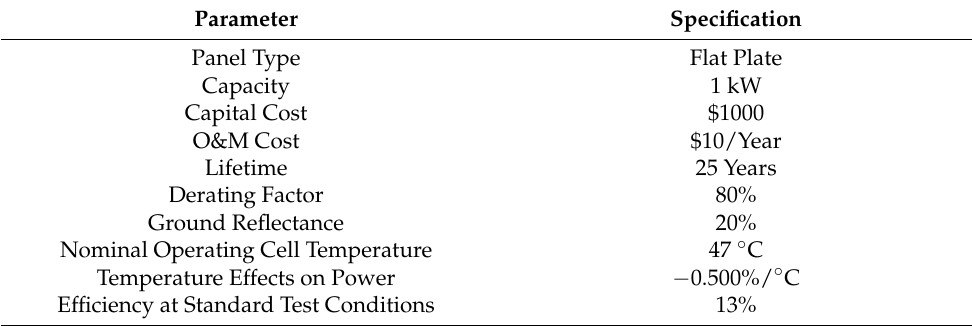
Table 1. Parameters of solar PV panels used in simulation in HOMER Pro. Figure 5. Microgrid configuration designed in HOMER.